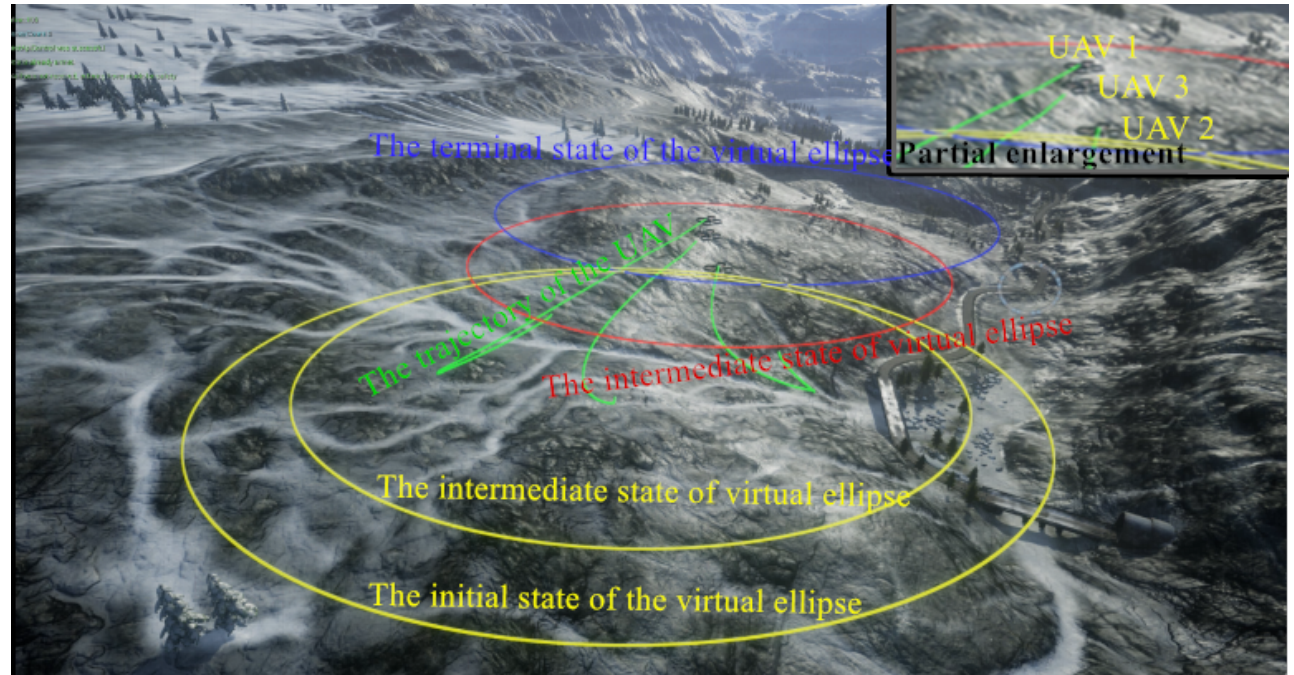
Figure 5. The movement of the UAV swarm corresponding to Figure 1.